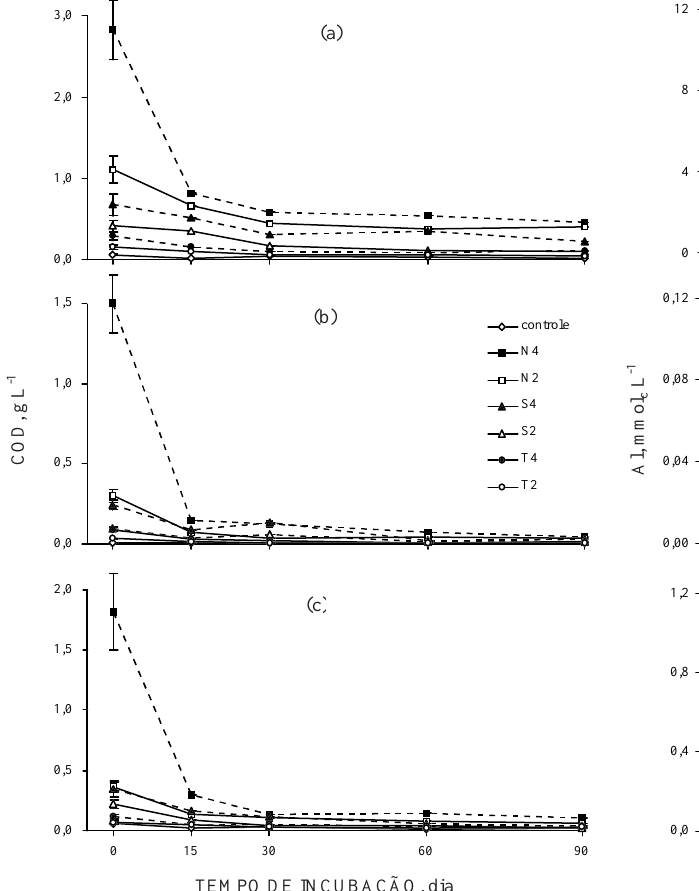
Figura 1. Efeito do tempo de incubação dos resíduos vegetais com o solo no teor de carbono orgânico dissolvido (COD). (a) Latossolo Vermelho- Amarelo, (b) Latossolo Roxo e (c) Latossolo Vermelho-Escuro. Barras verticais indicam o erro-padrão da média.